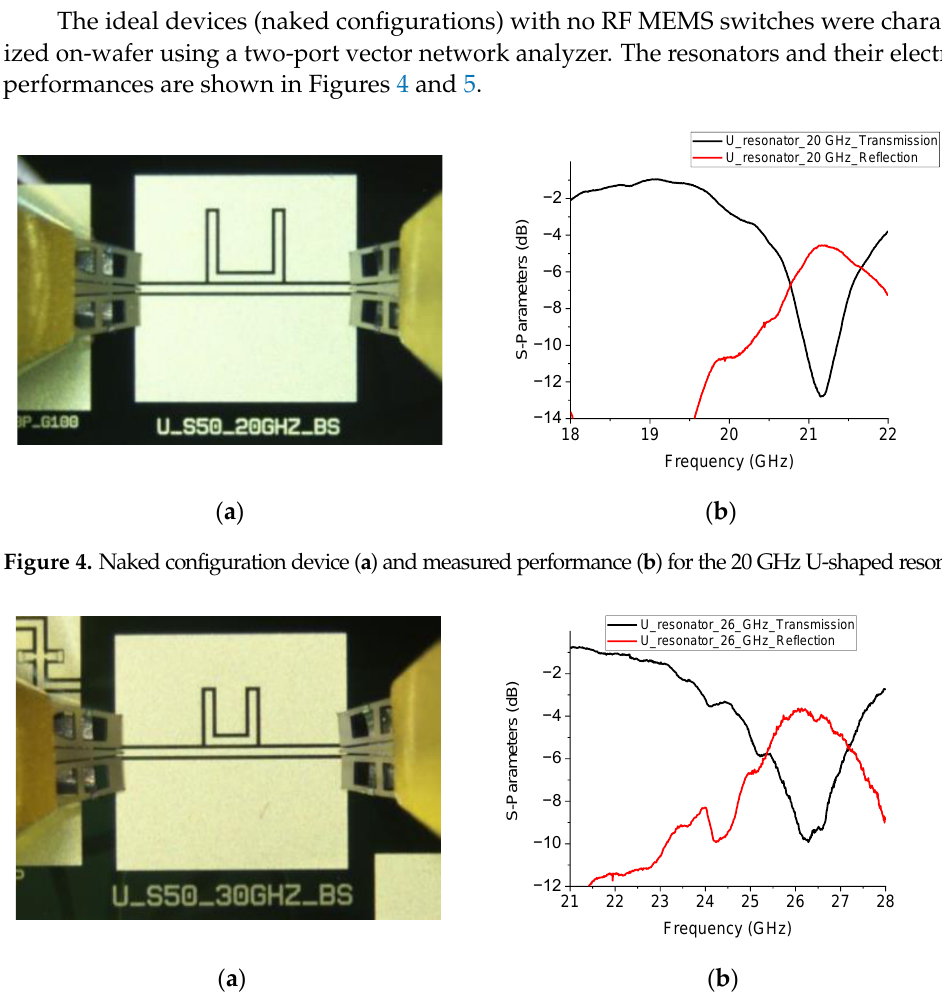
Figure 5. Naked configuration shape ( a ) and measured response ( b ) for the 26 GHz device.